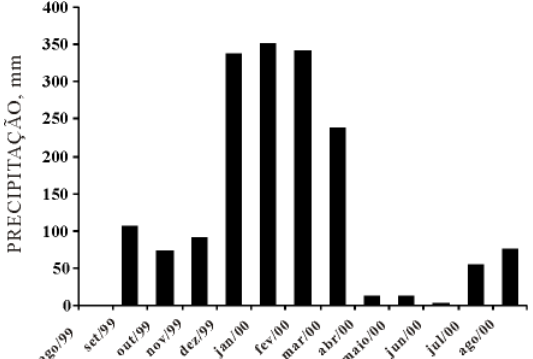
Figura 1. Precipitação mensal no ano/safra agrícola de 1999/2000 (Usina São Luiz - Dedini, em Pirassununga,